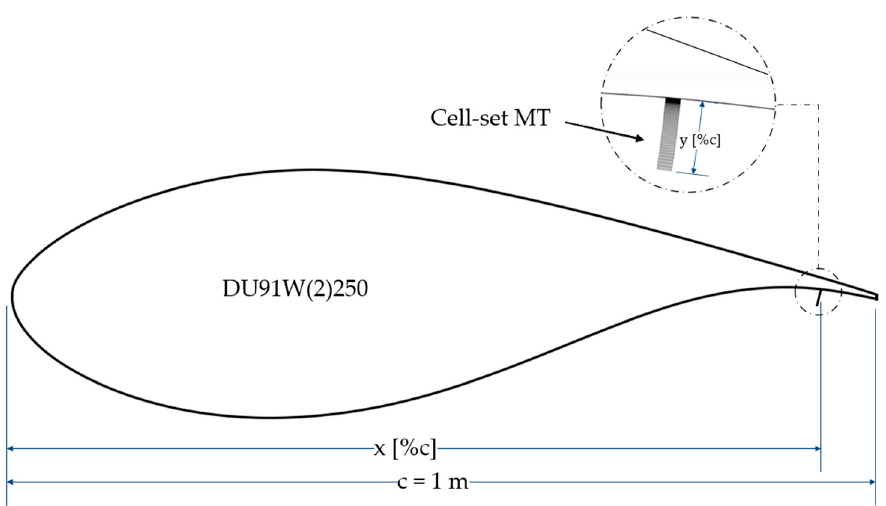
Figure 2. Sketch of the microtab (MT) setup. The relative position and length of the MT are determined by x [%c] and y [%c], respectively. The detail view shows an MT cell-set construction for an x [%c] = 93% and y [%c] = 1.0% configuration.